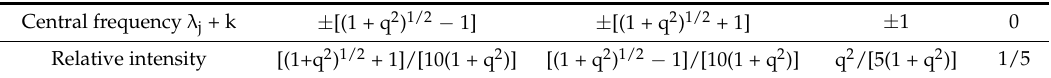
Table 5. Central frequencies λ j + k and relative intensities of components of the Ly-alpha line emitted by the inner electron. The central frequency is the frequency, at which the component has the primary maximum of the intensity for the zero eccentricity of the orbit of the outer, Rydberg electron. The frequencies are in units of the Kepler frequency Ω of the outer electron (given by Equation (12.3)) and they are counted from the unperturbed frequency of the spectral line. The sum of relative intensities of all the components is set to unity